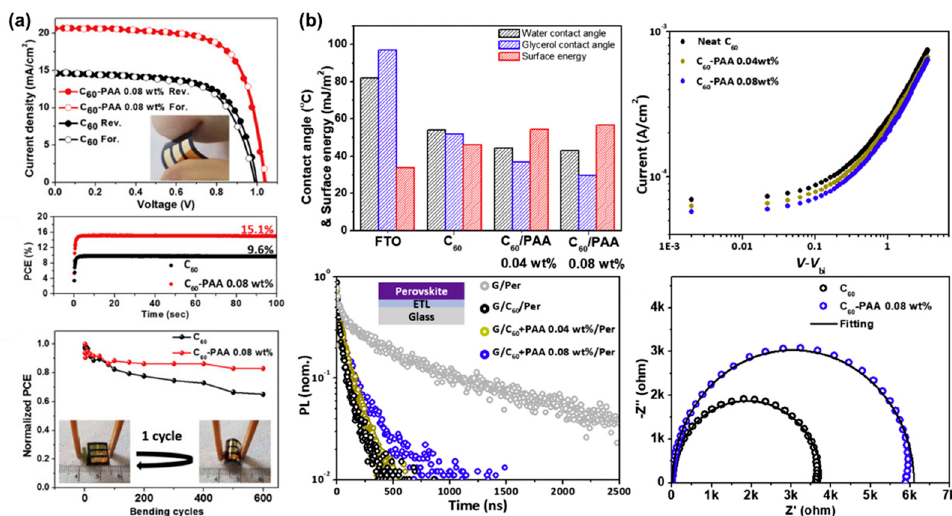
Figure 7. ( a ) J-V curve, device stability, and bending test of flexible perovskite solar cell using fullerene and poly(allylamine) (C 60 -PAA). ( b ) Contact angle, space charge limited current, time-resolved photoluminescence, and impedance analysis of FTO/C 60 -PAA based devices. Reprint with permission [99]; 2018, Elsevier.